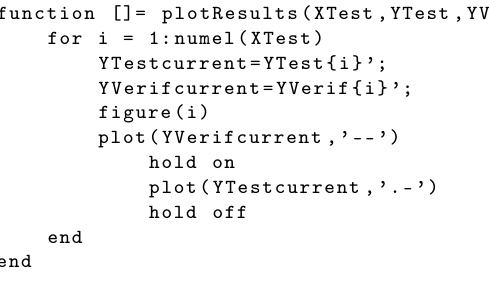
figure(i) plot(YVerifcurrent ,’--’) hold on plot(YTestcurrent